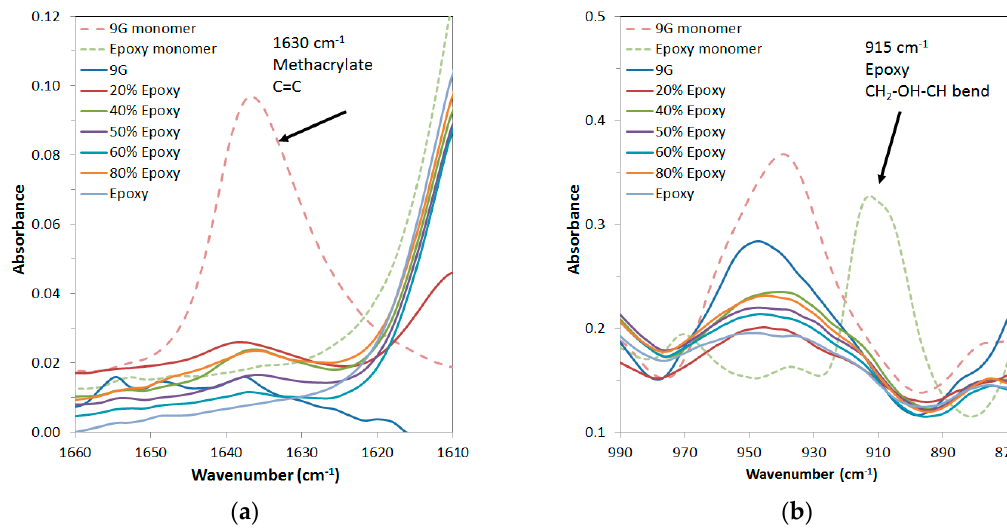
Figure 2. FTIR spectra of epoxy/methacrylate samples: ( a ) Epoxy CH 2 –OH–CH peak and ( b ) methacrylate C=C peak after completion of polymerisation steps.